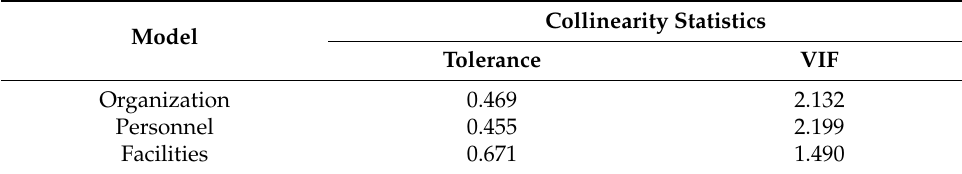
Table 5. Collinearity statistics for the model.